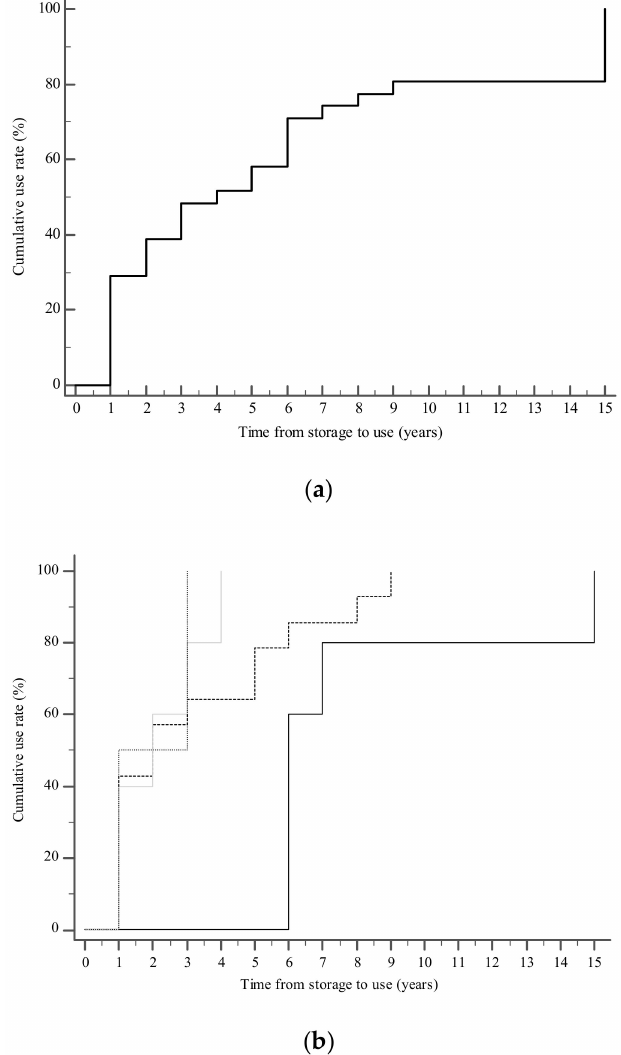
Figure 2. The cumulative rate of first use of frozen semen for the whole cohort ( a ) and according to the age at storage ( b ). The graph was plotted using Kaplan-Meier estimates. At the time of freezing, sperm concentration (40.0 ± 34.4 million/mL) and total motil- ity (50.4% ± 20.3%) were normal, although the high value of standard deviation signified the marked variability of the ejaculates. A concentration of spermatozoa below the lower reference limit (<15 million/mL) was found in only 27% (7/26) of patients. Among them, 71% (5/7) of cases were men diagnosed with malignant cancers at male genital apparatus (namely, three testicular tumors, one testicular seminoma, and one prostate cancer), one case was affected by chronic myeloid leukemia, and one by Hodgkin’s lymphoma. These patients had significantly fewer spermatozoa per semen sample compared with the other patients ( p = 0.0043). The lowest mean value of sperm count (0.01 million/mL) was found in a patient with chronic myeloid leukemia. Total sperm motility > 40% was found in 65% (17/26) of patients, and nobody showed sperm motility < 10%. The lowest percentage of motility (10%) was seen in a patient with a testicular tumor and one with testicular semi- noma. At post-thaw, a significant reduction of both concentration (10.4 ± 9.8 million/mL) and motility (16.0% ± 16.3%) was